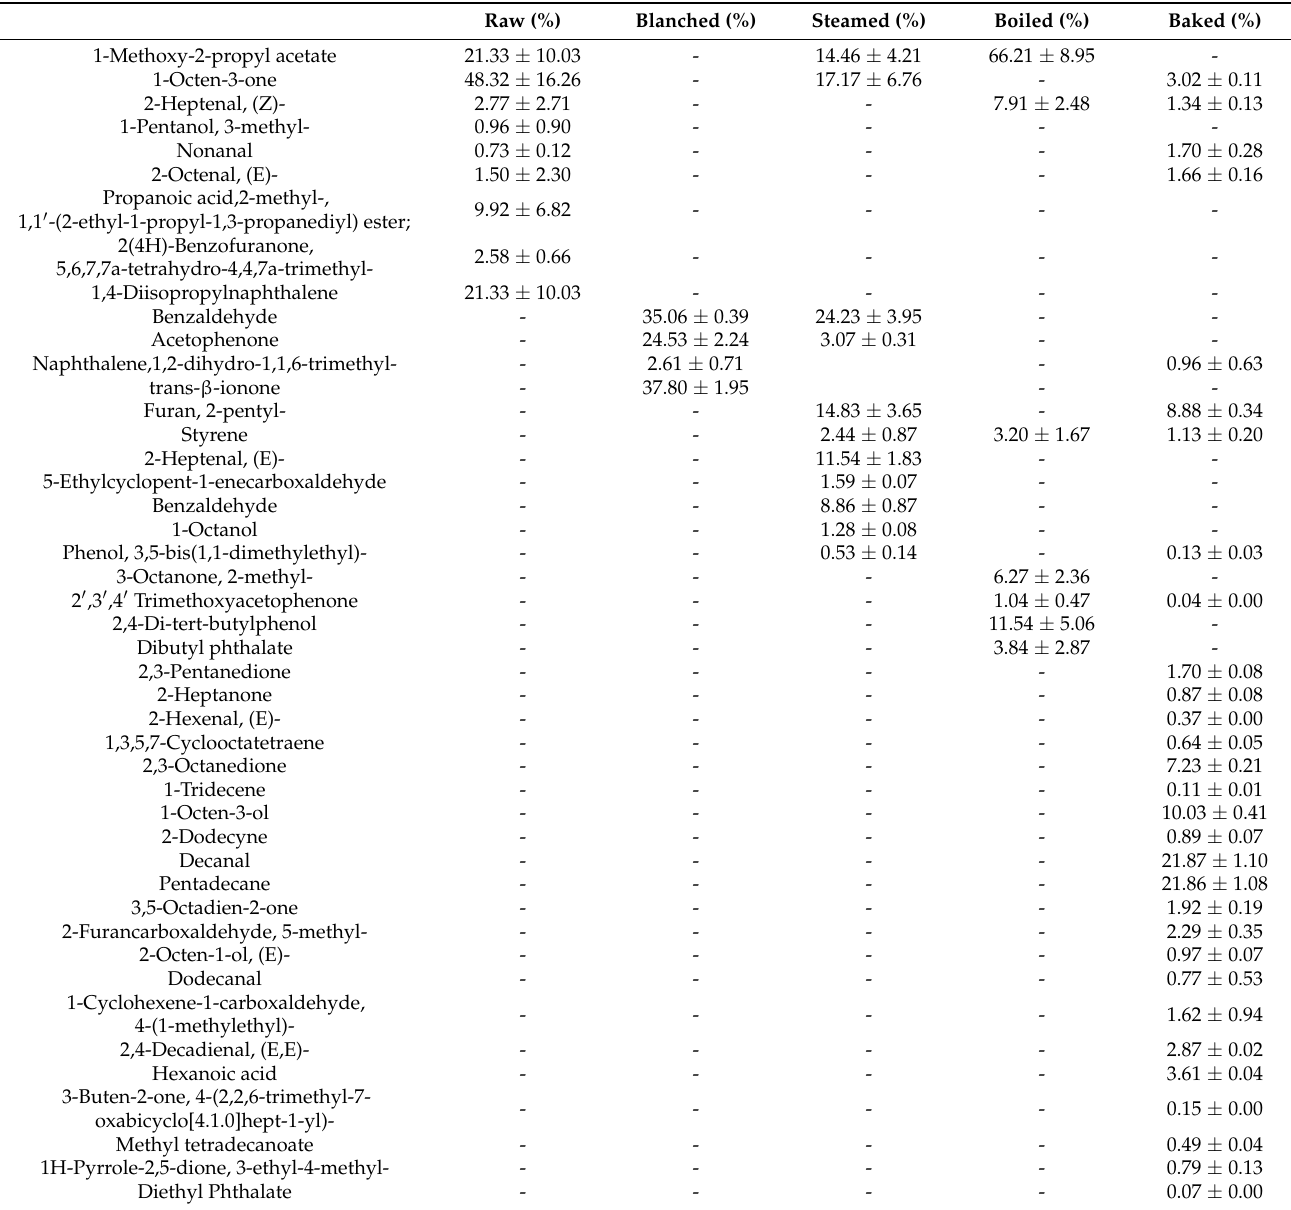
Table 3. Flavor compounds produced by different processing methods of L. japonica . Raw (%) Blanched (%) Steamed (%) Boiled (%) Baked